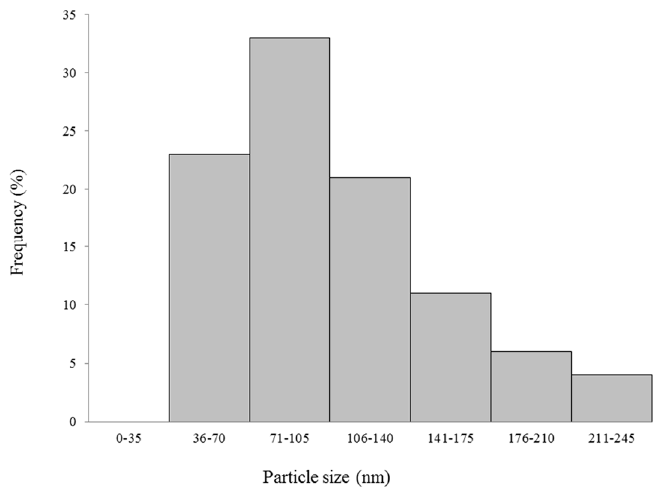
Figure 5. Size dispersion histogram obtained by dynamic light scattering (DLS).